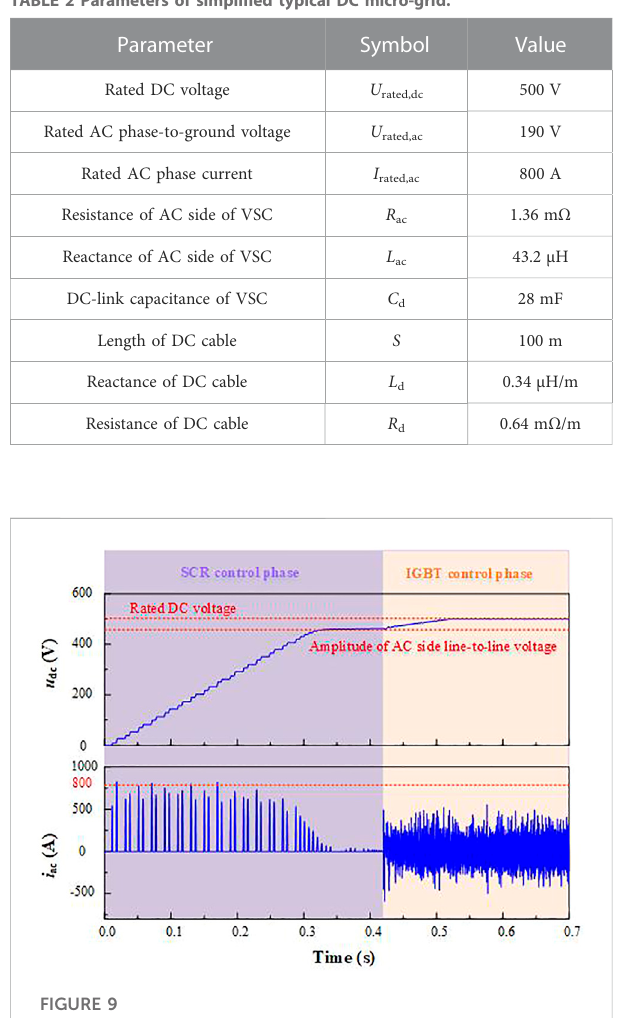
TABLE 2 Parameters of simpli fi ed typical DC micro-grid.